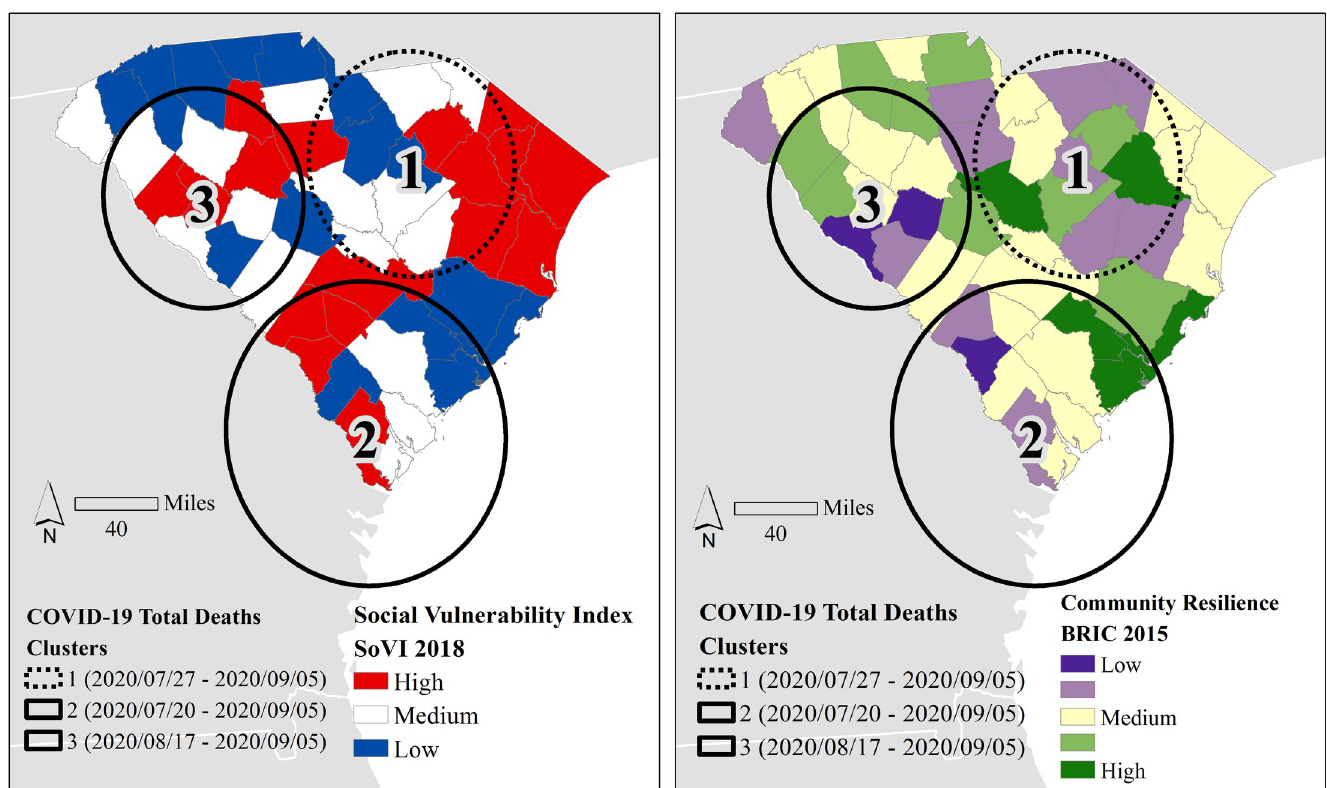
Fig 6. Space-time analysis clustering results for cumulative (a) total cases and (b) total deaths, March 1 st through September 5 th (epi weeks 10–36). Using county’s social vulnerability (left) and community resilience (right) as backdrops, the solid lines refer to high clusters, and dashed lines refer to low clusters. All clusters are significant ( p < . 001) . County and state boundaries are retrieved from the U.S. Census Bureau (https://www.census.gov/geographies/mapping-files/time-series/geo/